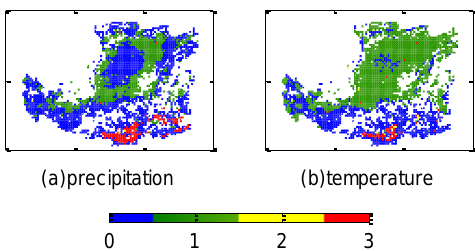
Figure 6. Time lag of climate impact on vegetation formulated by method 2; 0 represents no time lag, 1 represents one-month lag, 2 represents two-month lag, 3 represents three-month lag.